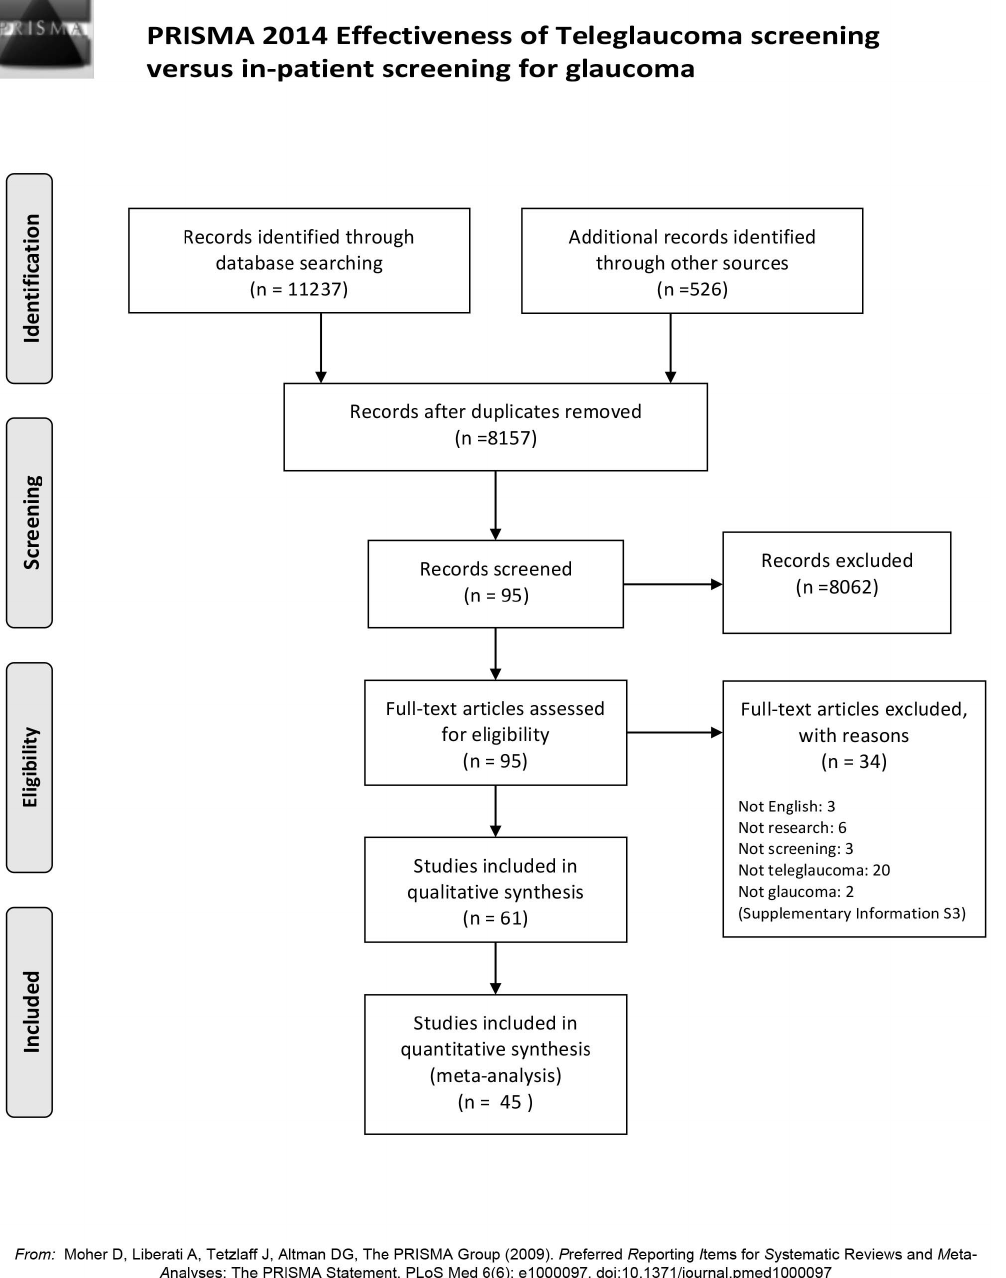
Figure 1. PRISMA diagram.